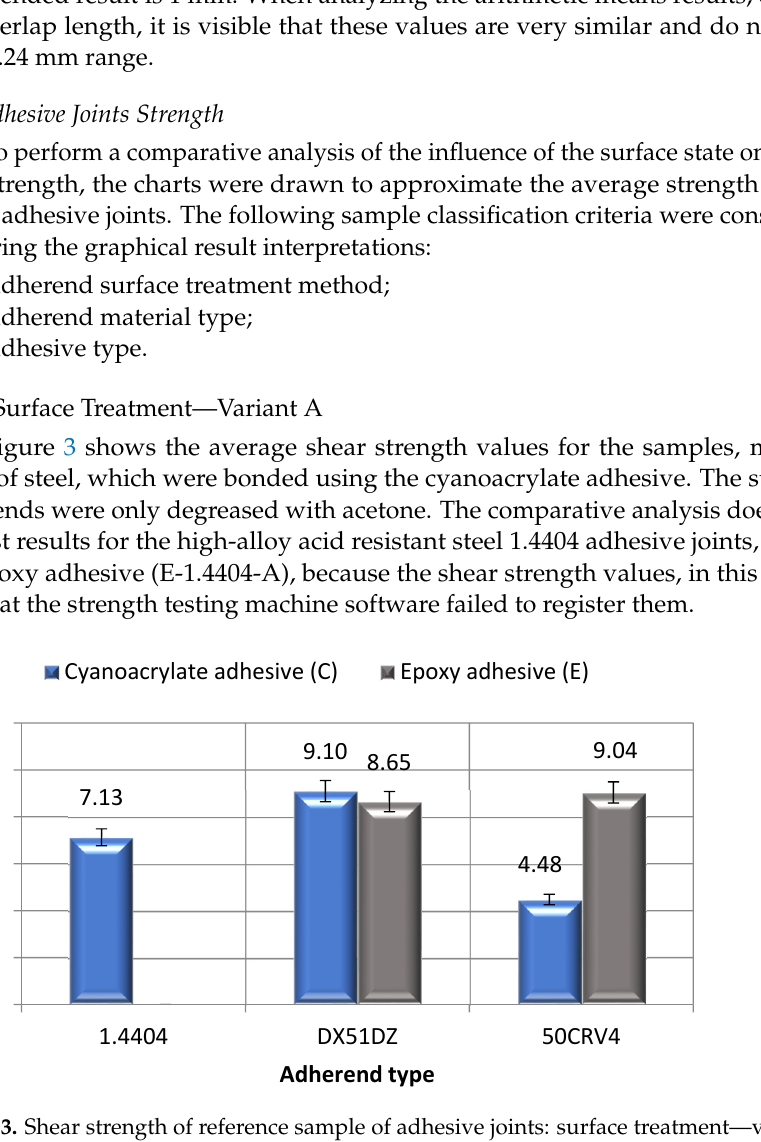
Figure 3. Shear strength of reference sample of adhesive joints: surface treatment—variant A.